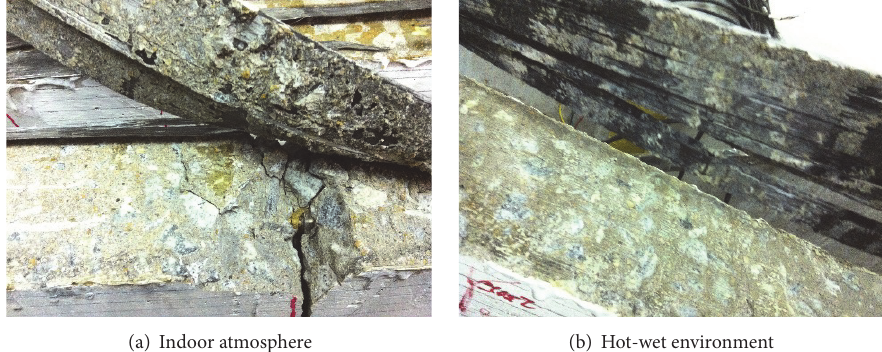
Figure 13: The sketch of debonded CFL at different environment.